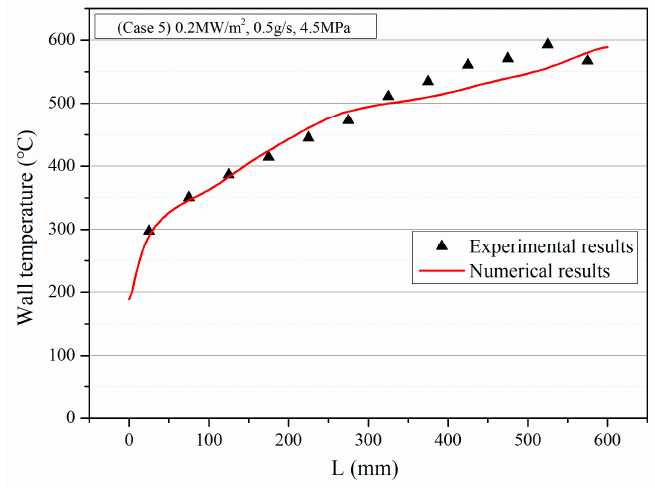
Figure 4. Comparison between simulated and measured wall temperatures of Case 5.